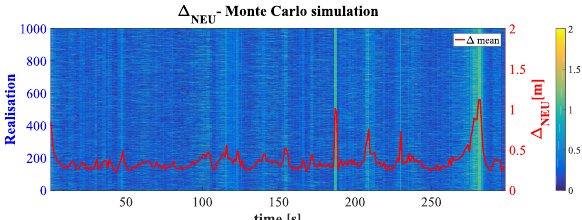
Figure 4. 3D deviations of the estimated trajectory wrt reference. Vehicle 1 - Sensor setup 1